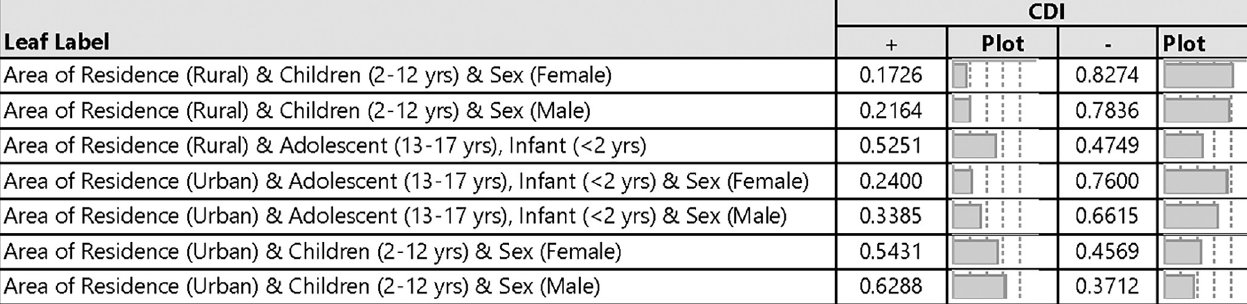
Fig 3. Response probability of toxigenic CDI among pediatric patients with